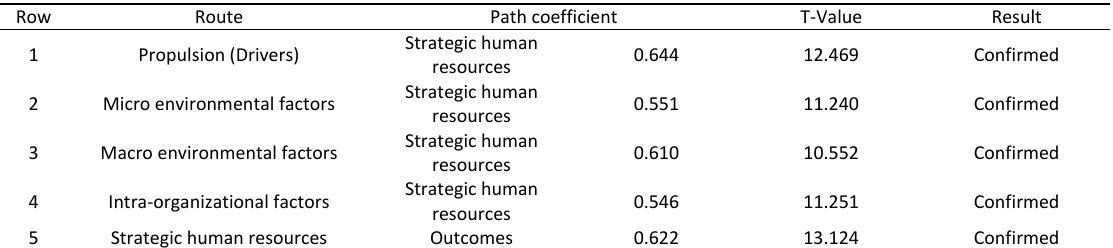
Table 4: Path analysis results